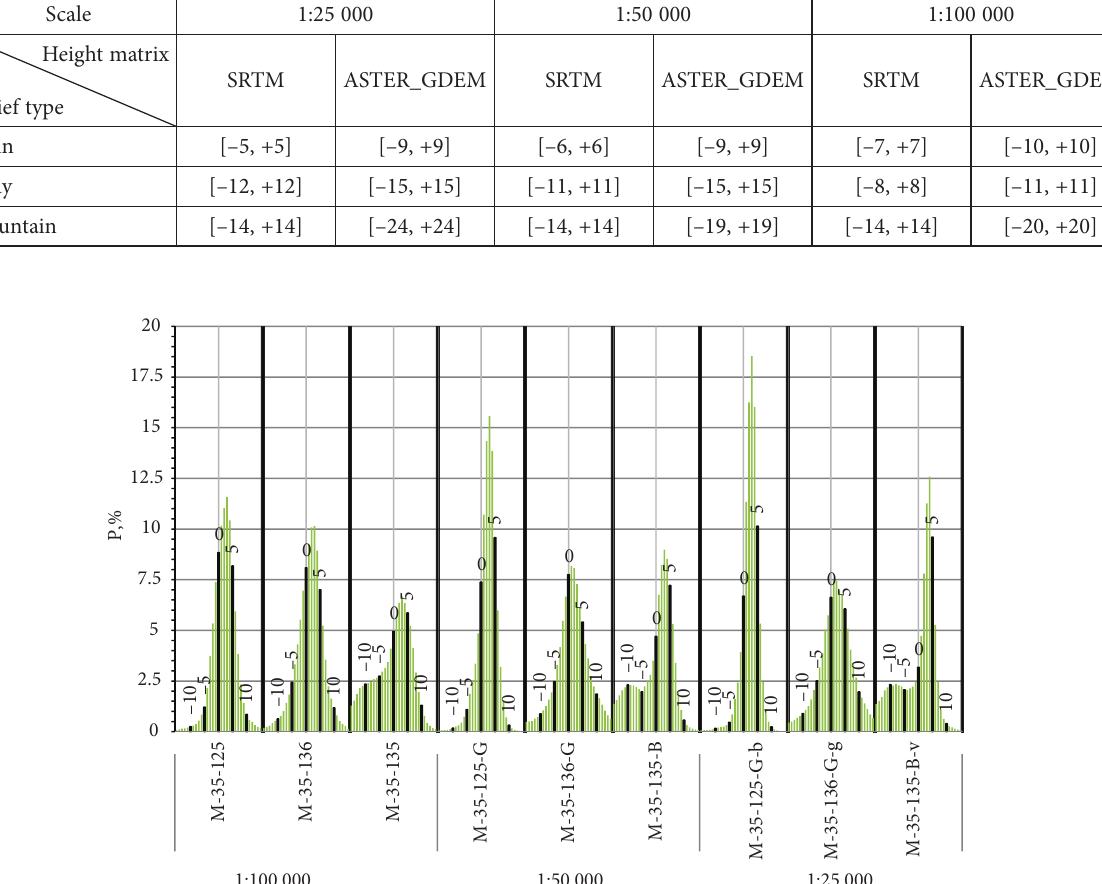
Table 3. Ranges of deviations of high-grade DTM markings satisfying the condition LE90 for different scale and conditions of